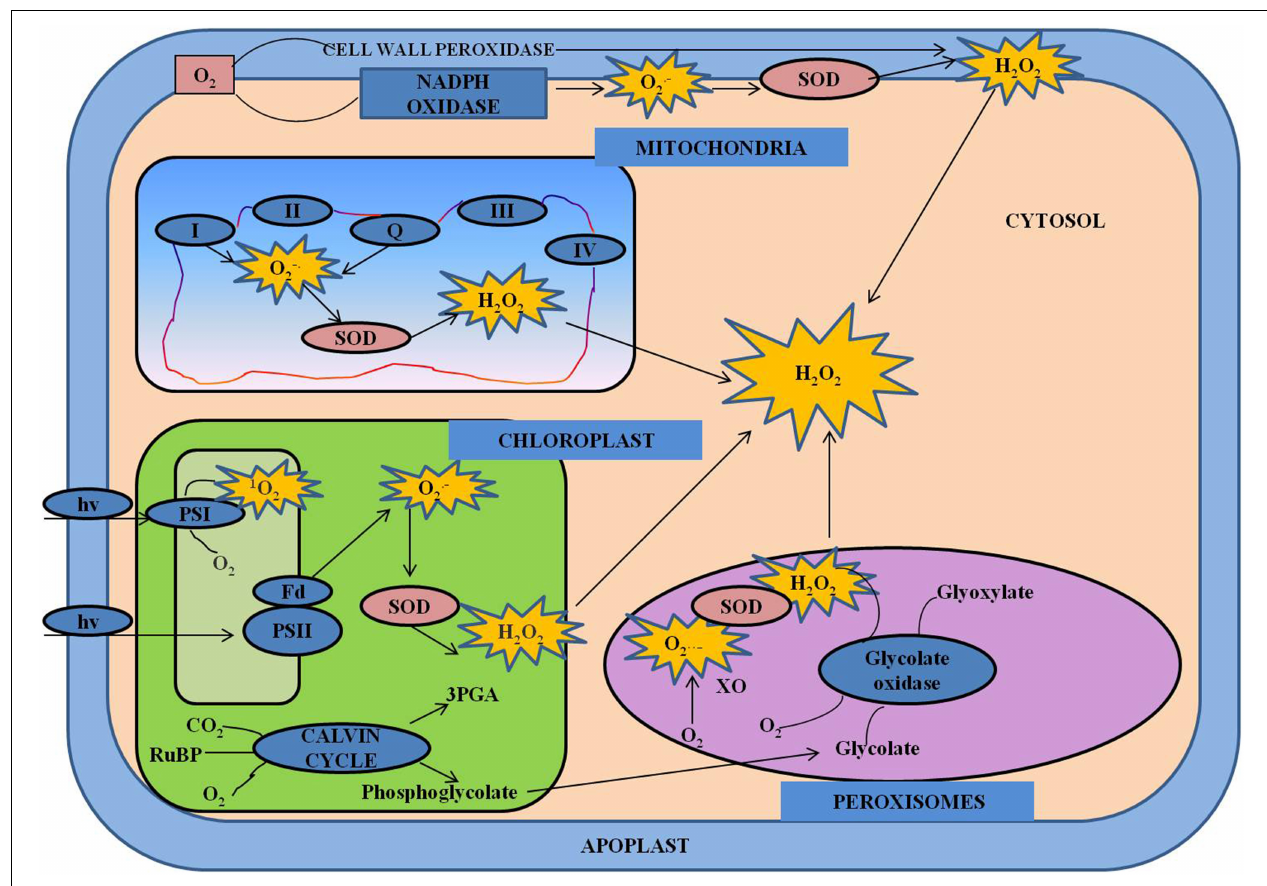
FIGURE 2 | Production of ROS in different organelles. During abiotic stress conditions organelles with highly oxidizing metabolic activities such as mitochondria, chloroplast and peroxisomes are major sites of ROS production (Mittler et al., 2004). In mitochondria, ROS production is likely to occur in complex I and Q zone (Blokhnia and Fagerstedt, 2006). In the chloroplast, during photosynthesis, energy from sunlight is captured